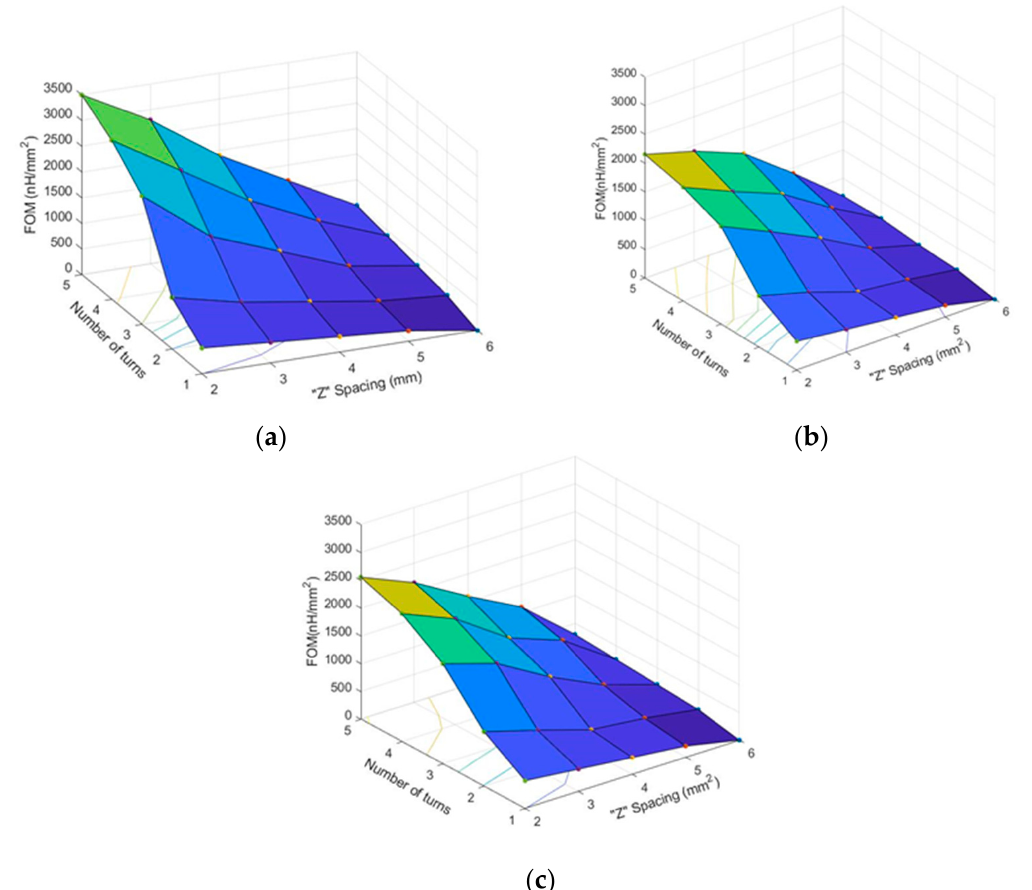
Figure 7. The Figure-Of-Merit (FOM) value as a function of number of turns and spacing between the coils for the square ( a ), hexagonal ( b ) and circular ( c ) designs, respectively.